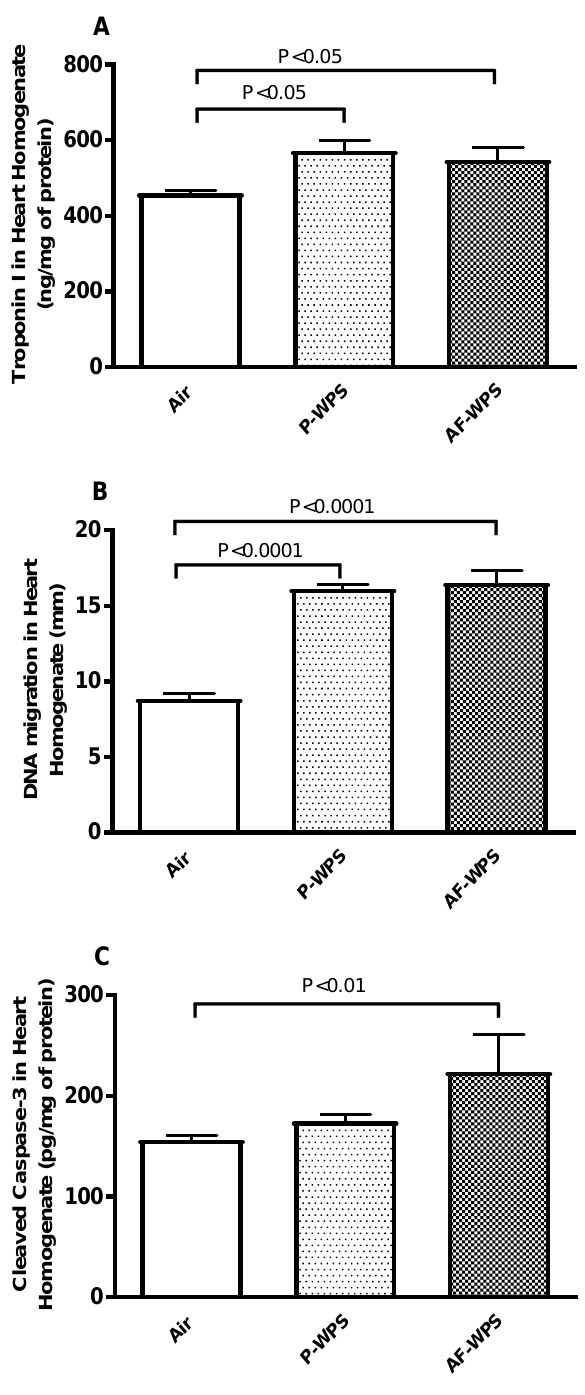
Figure 8. Effects of plain water-pipe smoke (P-WPS) or apple-flavoured (AF)-WPS on heart injury, DNA damage and apoptosis. Heart homogenate concentrations of troponin I ( A ), DNA migration (mm) in the heart assessed by Comet assay ( B ) and cleaved caspase-3 concentration ( C ) in heart homogenates at the end of 1 mo exposure period to either air or P-WPS or AF-WPS. Data are mean ± SEM (n = 5–7). Troponin I and DNA migration were analysed by one-way ANOVA followed by Holm–Sidak’s multiple comparison test, and cleaved caspase-3 was analysed with Kruskal–Wallis test followed by Dunn’s multiple comparison test.